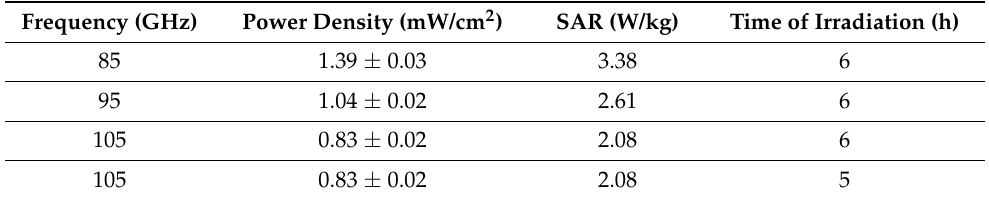
Table 1. Average energy flux at the aperture of the antenna for different frequencies (see an explana- tion and calculation in material and